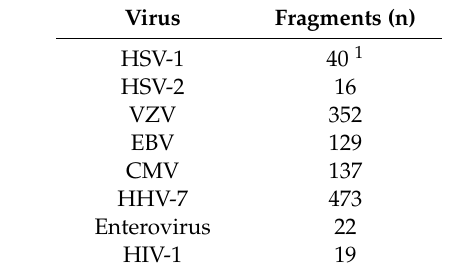
Figure 2. Background sequences in VIDISCA-NGS. Green dots: samples that were positive by VIDISCA-NGS, white dots: samples that were negative by VIDISCA-NGS, orange dots: the four samples containing an RNA virus not found by VIDISCA-NGS. On top the p -values are shown for the Mann-Whitney U test between the positive and negative VIDISCA-NGS samples. “Human” indicates human mitochondrial or genomic background, “Bacterial” indicates prokaryotic background, “Ambiguous” represents sequences with simultaneous hits to eukaryotes and prokaryotes, and “Unknown” are the sequences that do not match with any reference sequence. Table 1. Putative number of VIDISCA fragments per